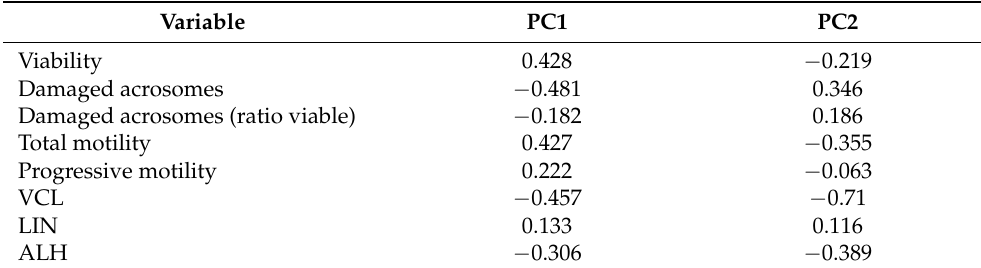
Figure 1. Principal components plot of the distribution of the males used in the first experiment for testing the resistance of their spermatozoa to the cold-shock test ( n = 65). The four groups obtained with the k-means algorithm were distributed in pairs along the two axes defined by the two first principal components (PC1 and PC2, with 57% and 27% of the variance explained, respectively). PC1 separated groups “high” (higher viability and motility) from “low”, with PC2 separating “above” (higher velocity and motility) from “below”. The arrows show the loadings (a measure of association) of each variable relative to PC1 and PC2. The variables used in the clustering were total motility (mot), progressive motility (prog), curvilinear velocity (vlc), linearity (lin), the amplitude of the lateral movement of the head (ALH), viability (viab), total damaged acrosomes (acrd), and the proportion of viable spermatozoa with damaged acrosomes (acrdr). Five males from each “high” and “low” group were selected for producing the two pools of seminal plasma for the second experiment. Table 2. Variable loadings for the two first principal components (PC) plotted in Figure 1 ( n = 65). The variance explained was 57% for PC1 and 27% for